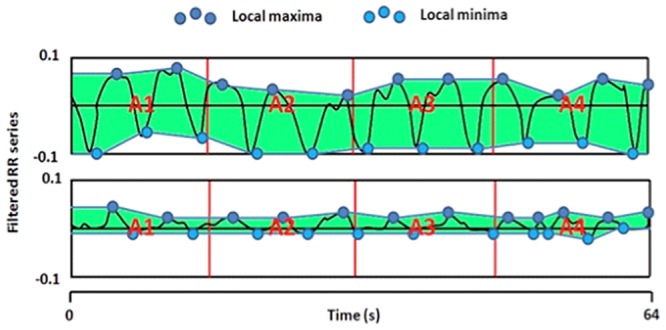
Mean centered, normalized and band pass-filtered RR series in 2 different levels of pain: without any painful stimulus (upper panel), under painful stimulus (lower panel).